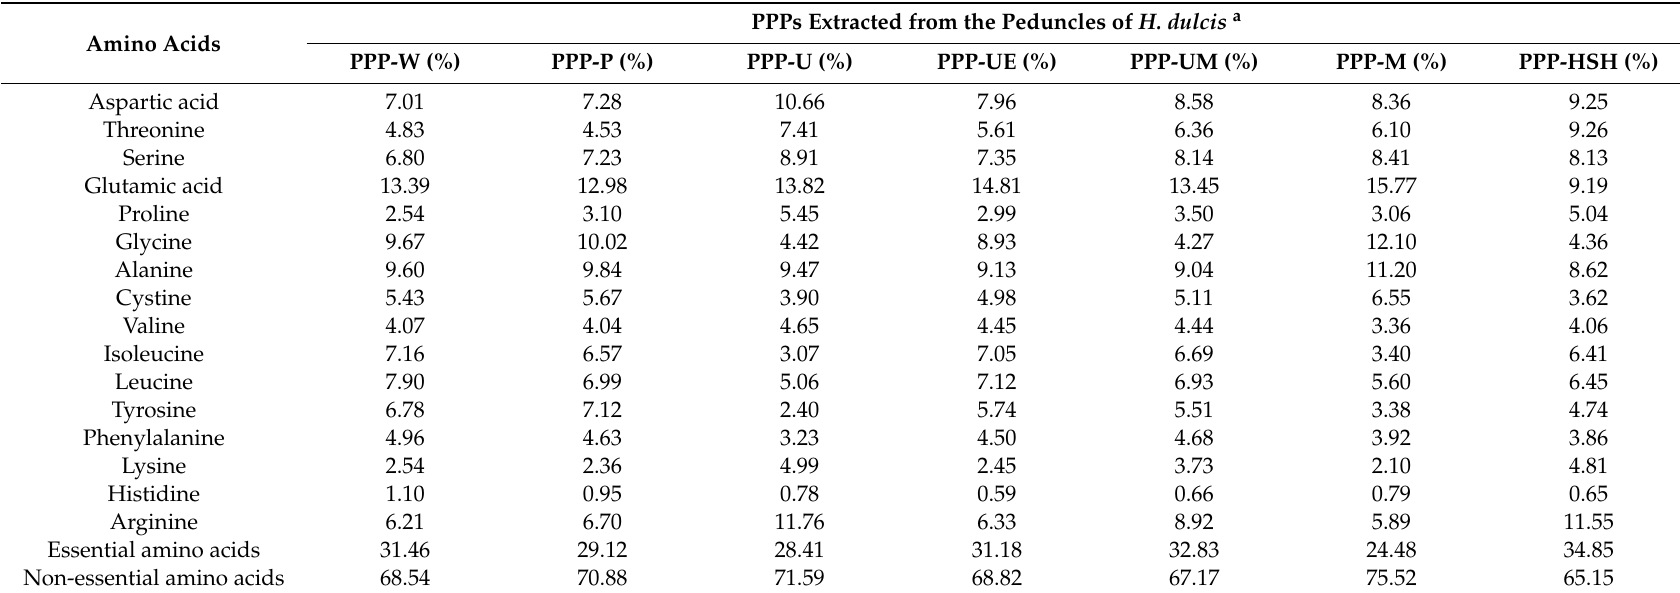
Table 3. Amino acid compositions of PPPs obtained by seven extraction